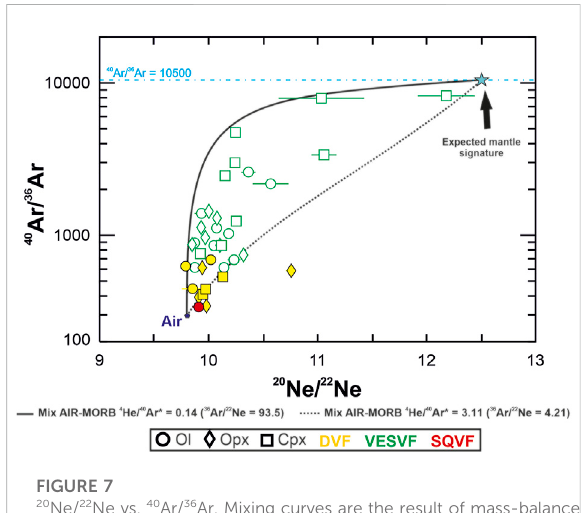
FIGURE 7 20 Ne/ 22 Ne vs. 40 Ar/ 36 Ar. Mixing curves are the result of mass-balance and isotopic mass balance equations using the parameters reported in Section 6.1.2. Modi fi ed from Sandoval-Velasquez et al.